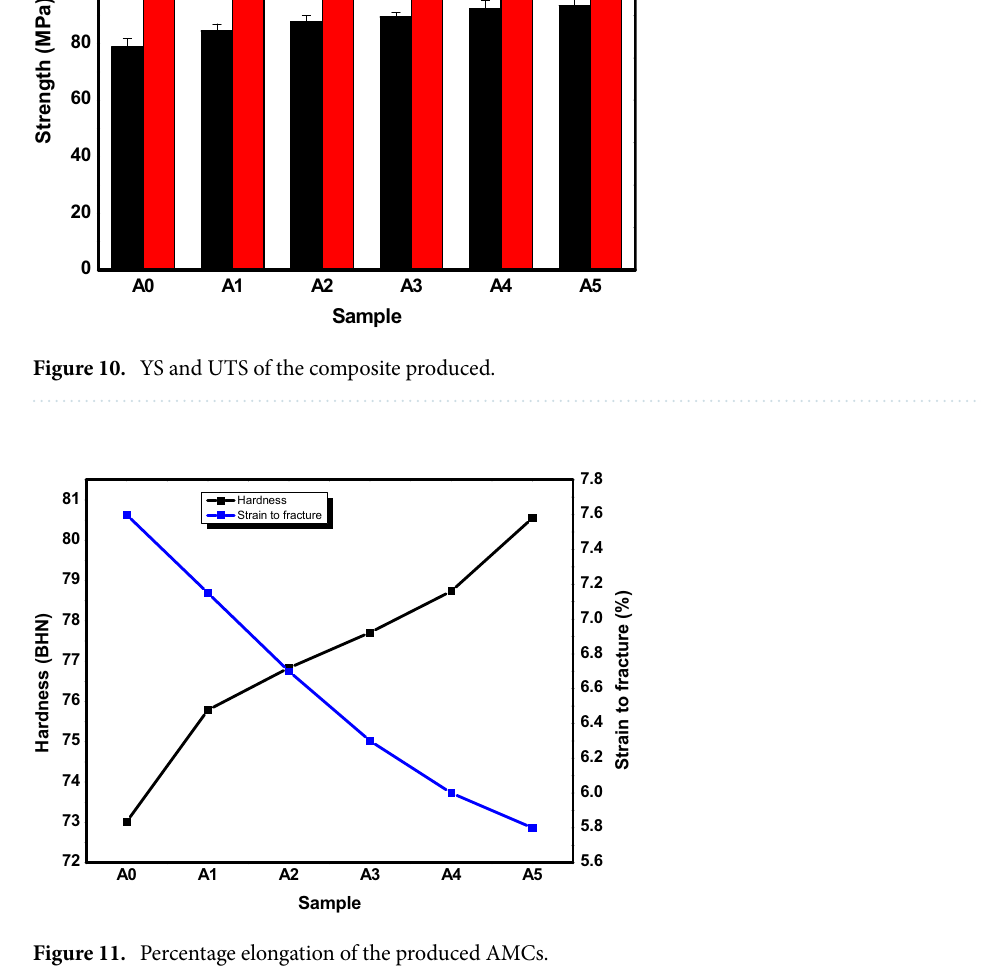
Figure 11. Percentage elongation of the produced